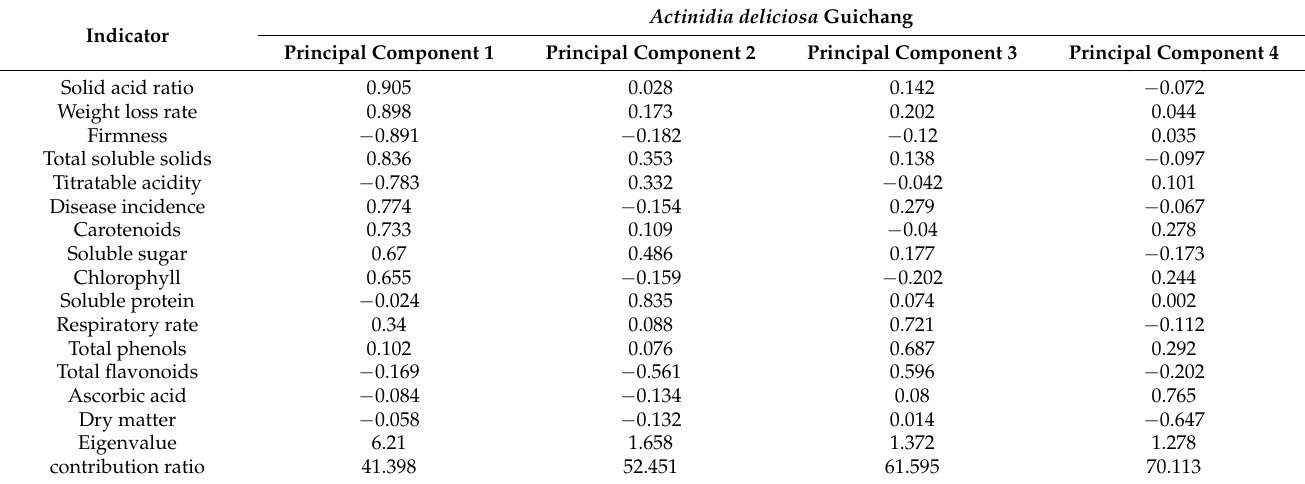
Table 4. Rotated component matrix of principal component analysis.